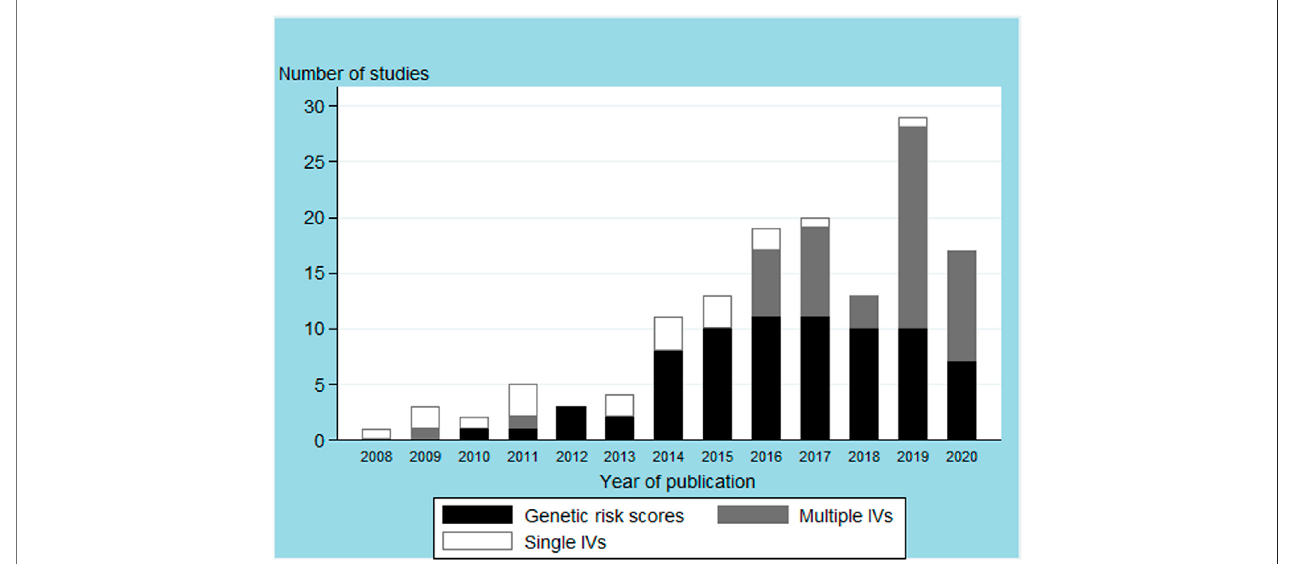
FIGURE 2 | Body mass index instrumental variables (IVs) used in the main analysis by article publication year.